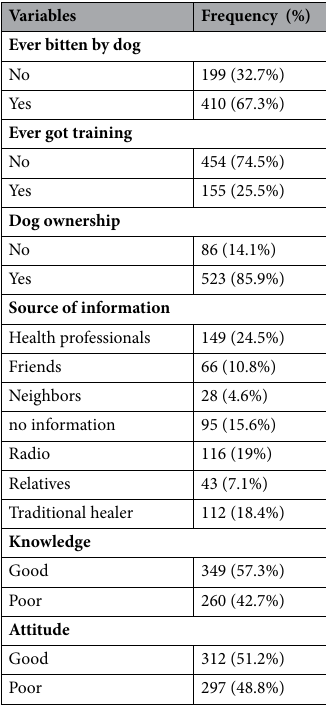
Table 2. The personal factors, knowledge and attitude of study participants towards rabies prevention and control practices in Bure Zuria District, North West